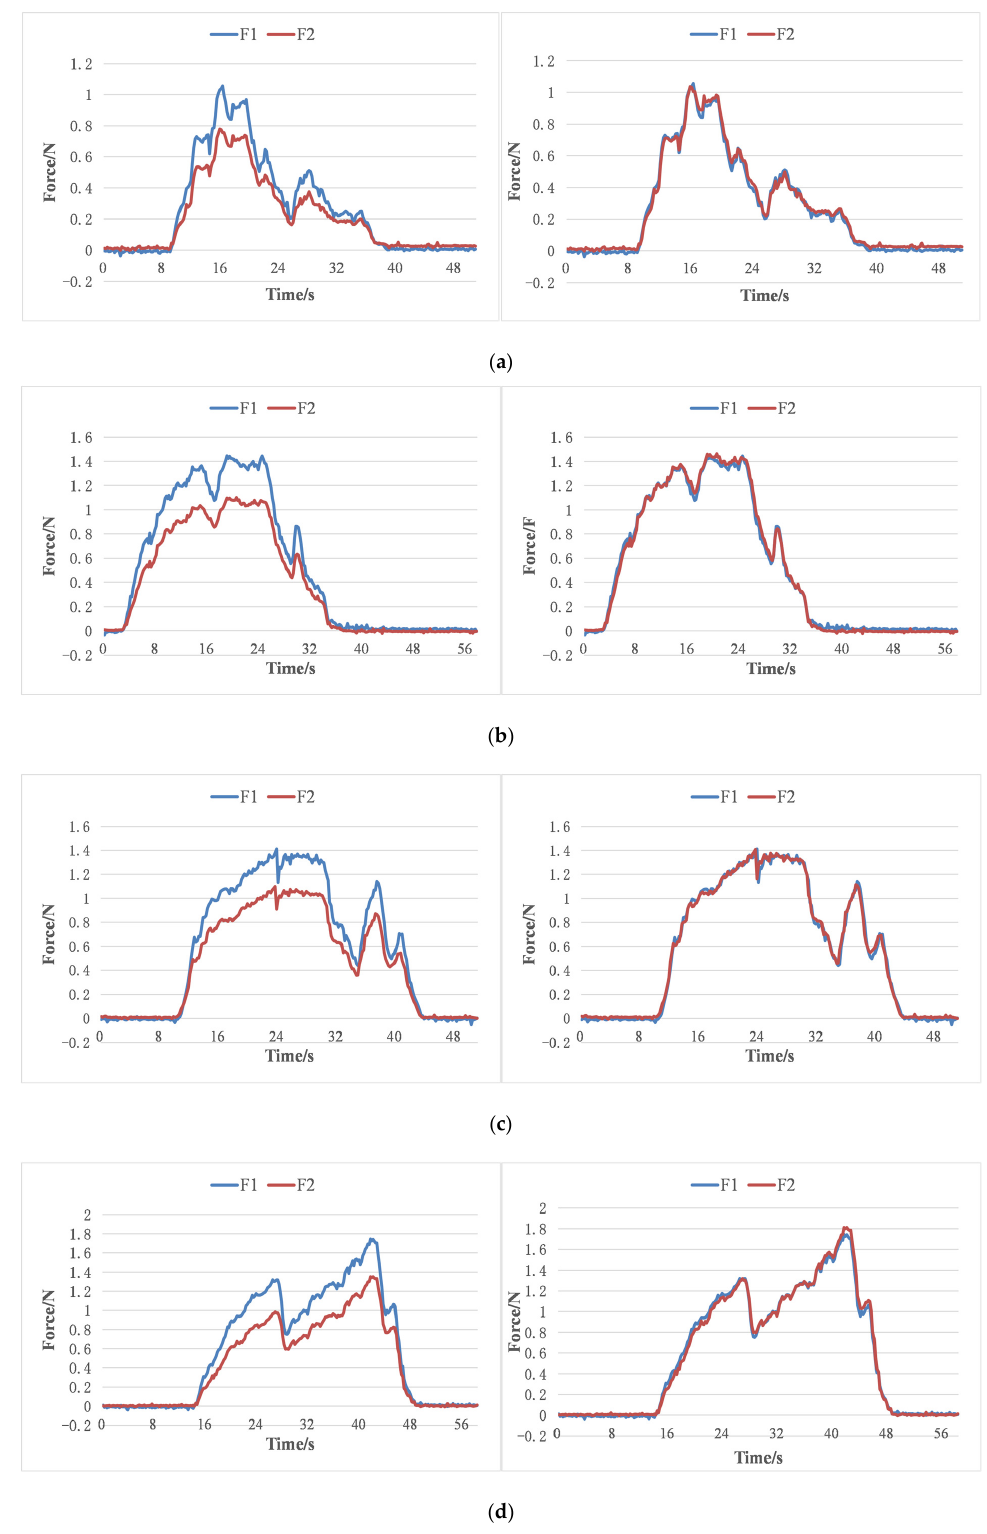
Figure 12. Axial force calibration tests were repeated 4 times. ( a ) Original data ( left ) and processed data ( right ) in the first test; ( b ) original data ( left ) and processed data ( right ) in the second test; ( c ) original data ( left ) and processed data ( right ) in the third test; ( d ) original data ( left ) and processed data ( right ) in the fourth test. As shown in Figure 12, the F1 is greater than F2. L1 and the rod are directly connected through the coupling. Because the detection method is direct, it can be said that F1 is the rod’s axial force. The axial force is transmitted to L2 through slider B, the flexible material, and integrated grasper A and B. The force detection method in the slave system is indirect.